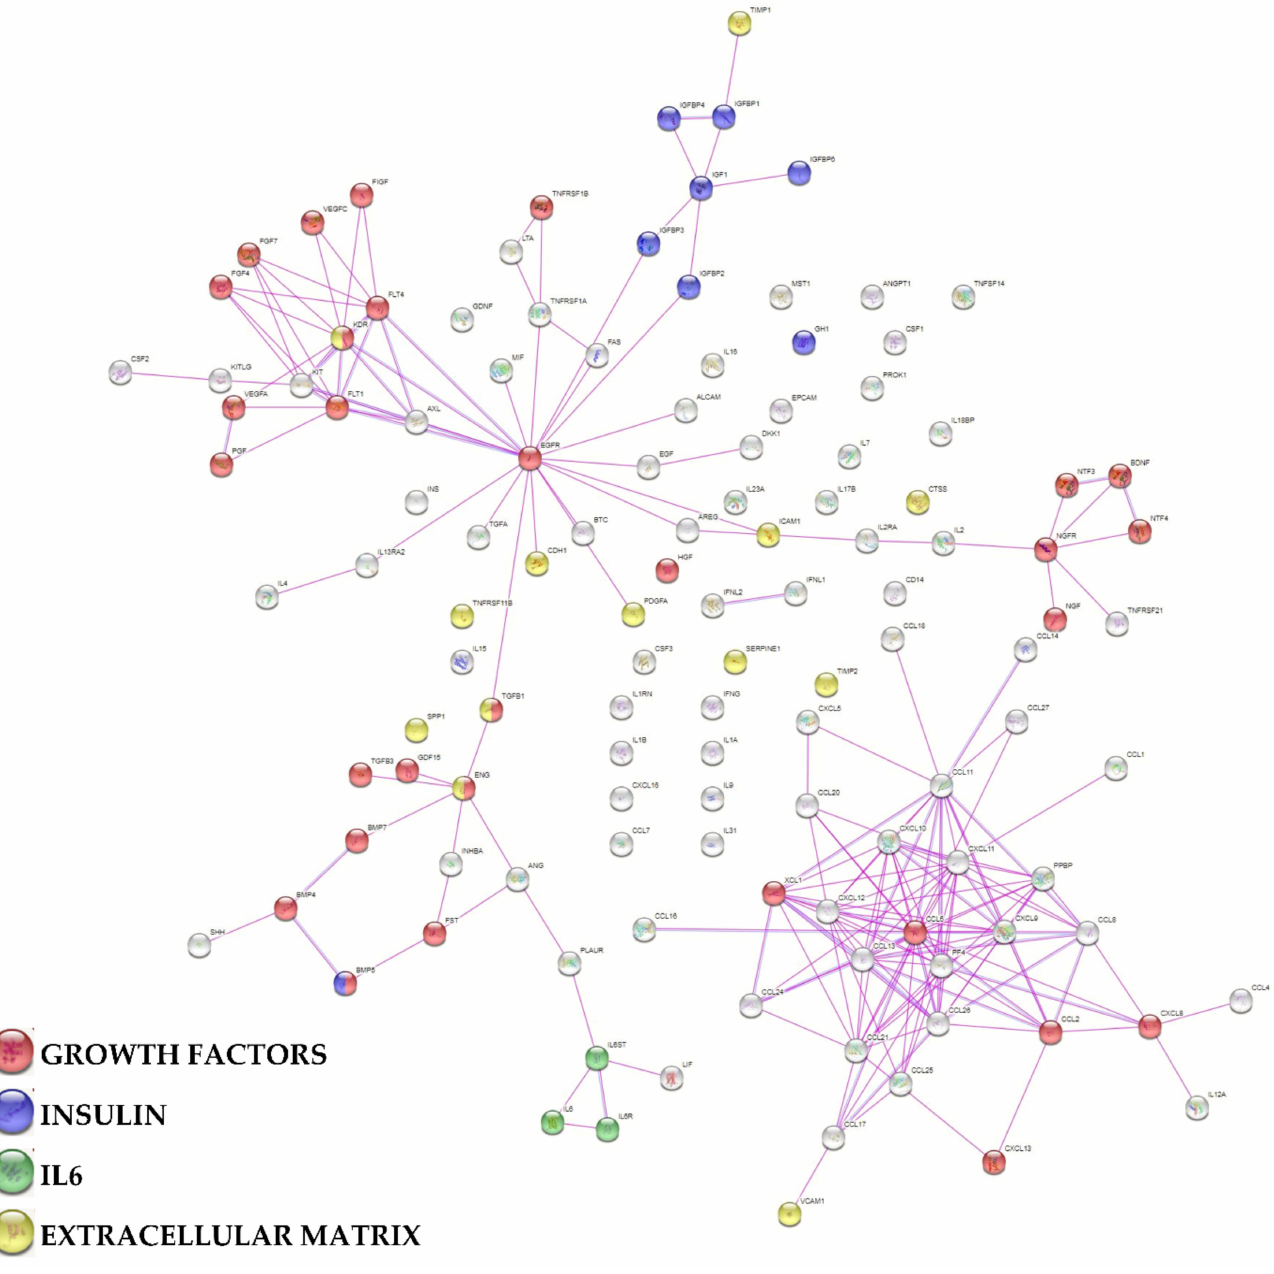
Figure 4. Functional association network for identified secreted factors released by SF-treated BMSCs. Using the online tool STRING, protein-protein interaction levels for 125 proteins of the BMSCs secretome were mined. The blue connections are for proteins with known interactions based on curated databases; violet connections for proteins with experimentally determined interactions. Empty nodes, proteins of unknown 3D structure; filled nodes, known or predicted 3D structure. Growth factors, insulin, IL6 and extracellular matrix related factors are